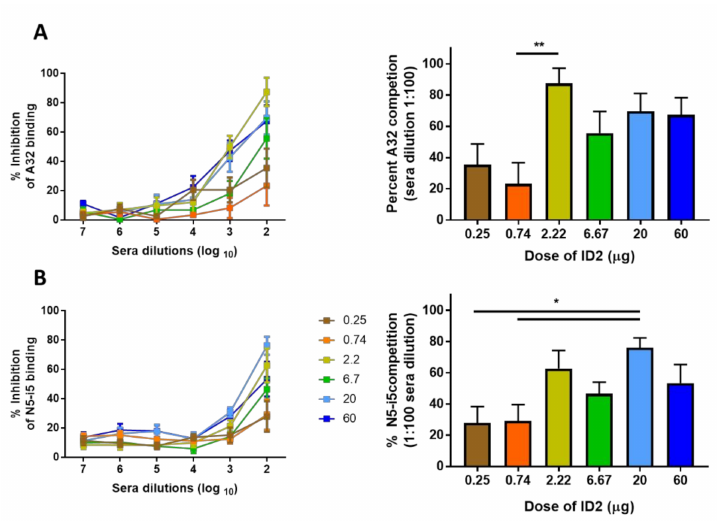
Figure 3. Ability of ID-2 immunized sera to compete with A32 and N5-i5 for ID2 binding. Competition ELISA to determine the level of competition of immunized sera with ( A ) A32 and ( B ) N5-i5. Sera were mixed 1:1 with a biotinylated antibody at a concentration equivalent to the half-max binding against ID2 and analyzed for % competition. Sera from each mouse were analyzed in triplicate over a 10-fold dilution beginning at 1:100 (Left panels) with % competition at 1:100 dilution displayed in right panels. n = 6 mice for each group, sera were evaluated for each mouse in triplicate and displayed as mean ± SEM. Statistical significance was determined using a one-way ANOVA with Tukey’s test for multiple comparisons. Significance values are indicated as * p < 0.05, ** p <